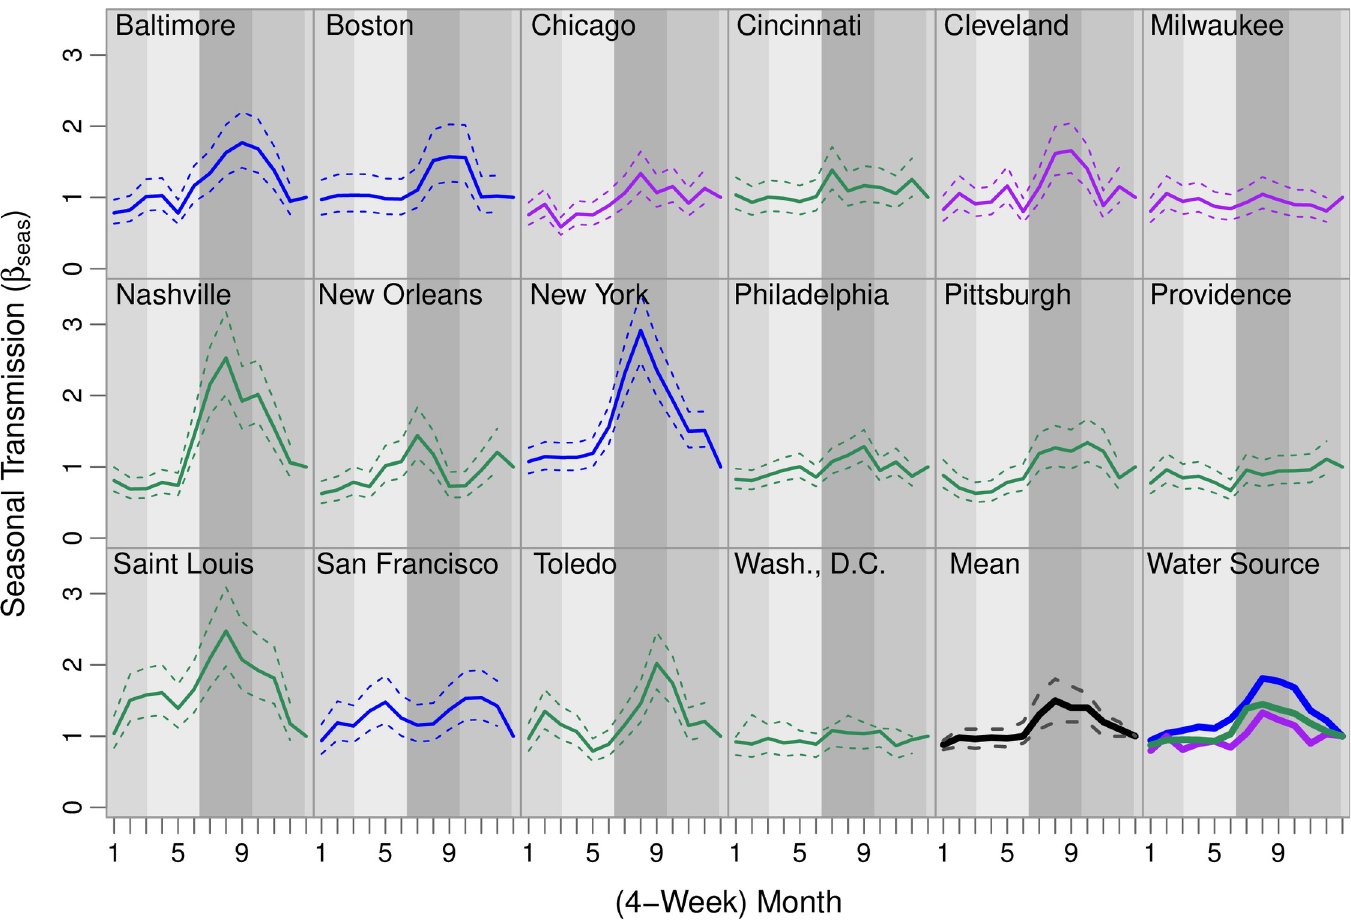
Fig 2. Long-term typhoid transmission rate by city estimated from Time-series Susceptible-Infectious-Recovered models. The estimated long-term transmission rate ( β lt , solid black line) is plotted for each city, by four-week generation interval. Overall per capita investments in the water supply (blue circles) and sewer system (green pluses) in 1931 US dollars are also shown for each city from 1902–1931.